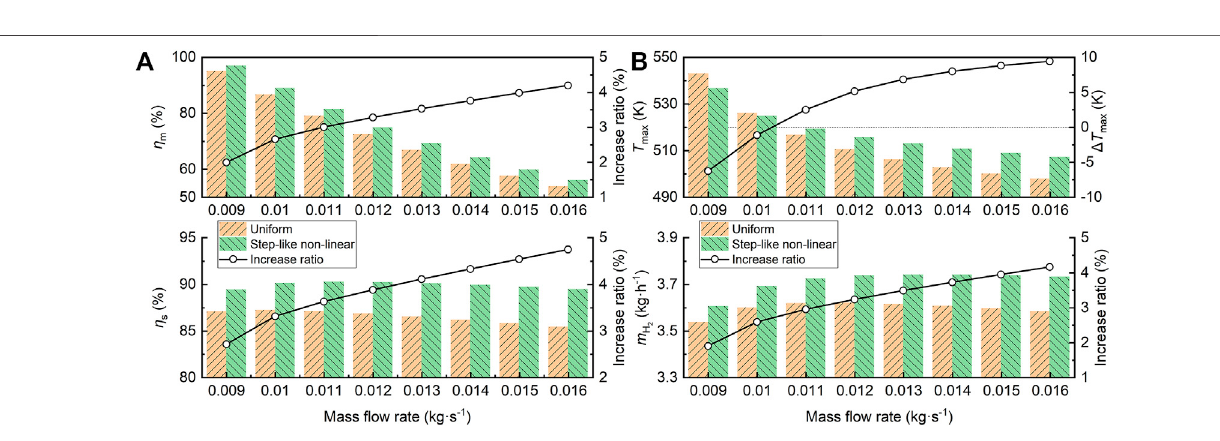
Frontiers in Energy Research |